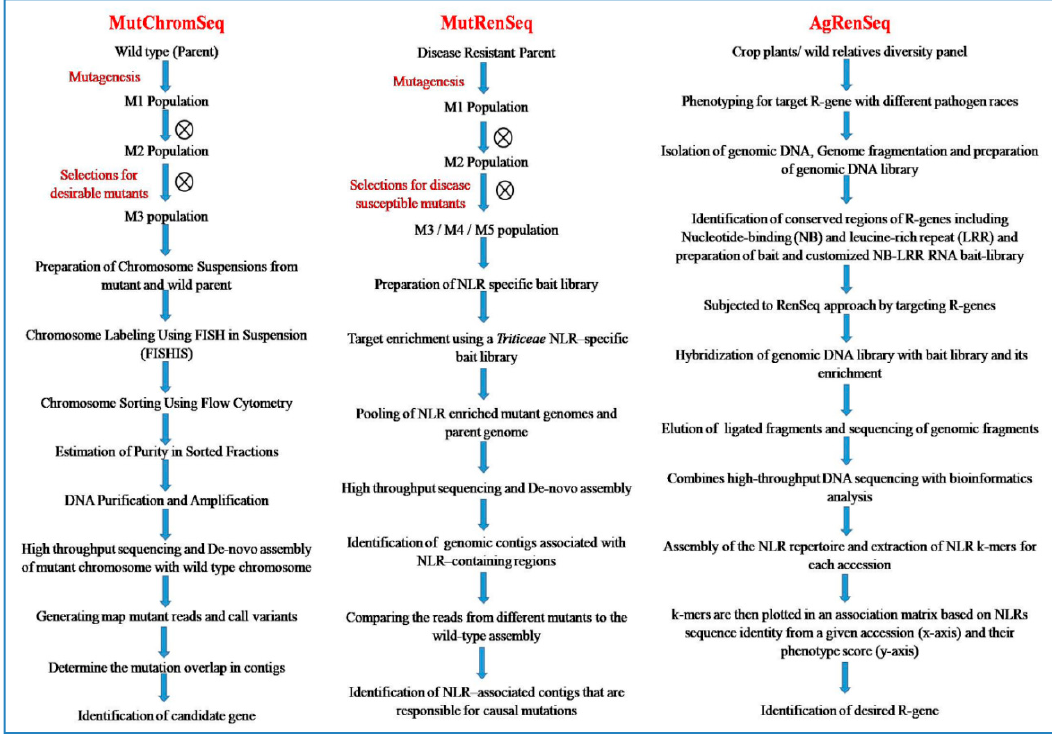
Figure 7. Flow diagram showing the major steps of MutChromSeq, MutRenSeq, and AgRenSeq